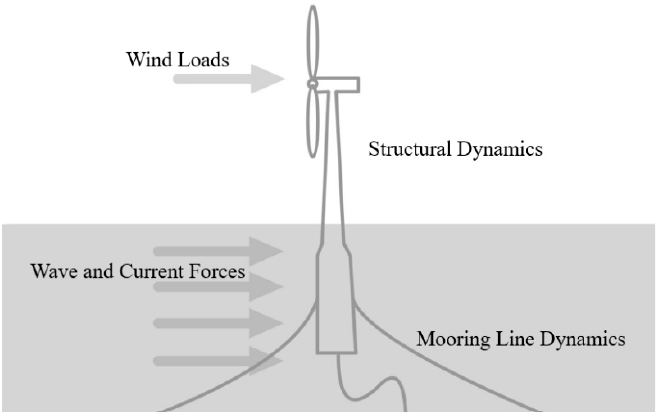
Figure 3. Sketch of environmental loads on a floating offshore wind turbine.